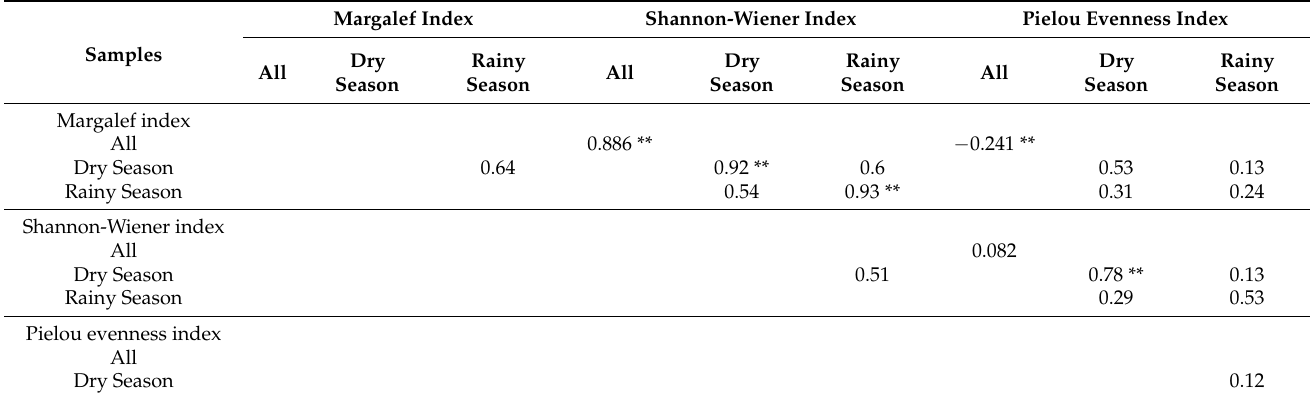
Table 5. The correlation coefficients found by CA of diversity indices in Jingpo Lake during the study